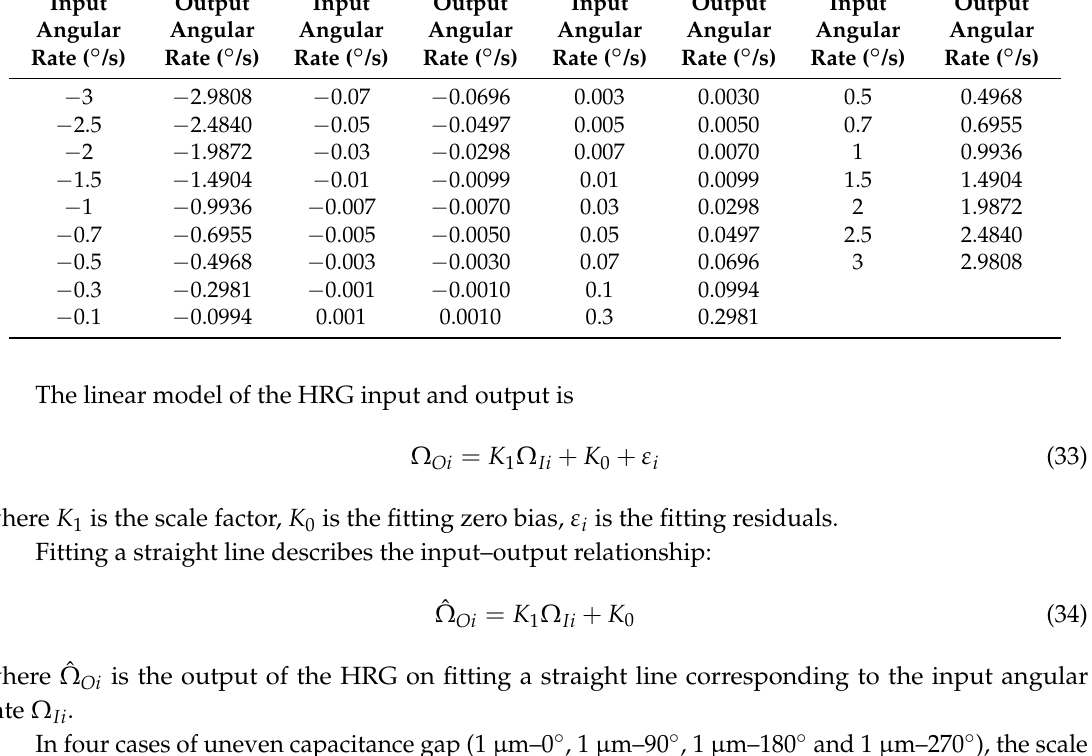
Table 2. HRG output for 1 µ m–0 ◦ uneven capacitance